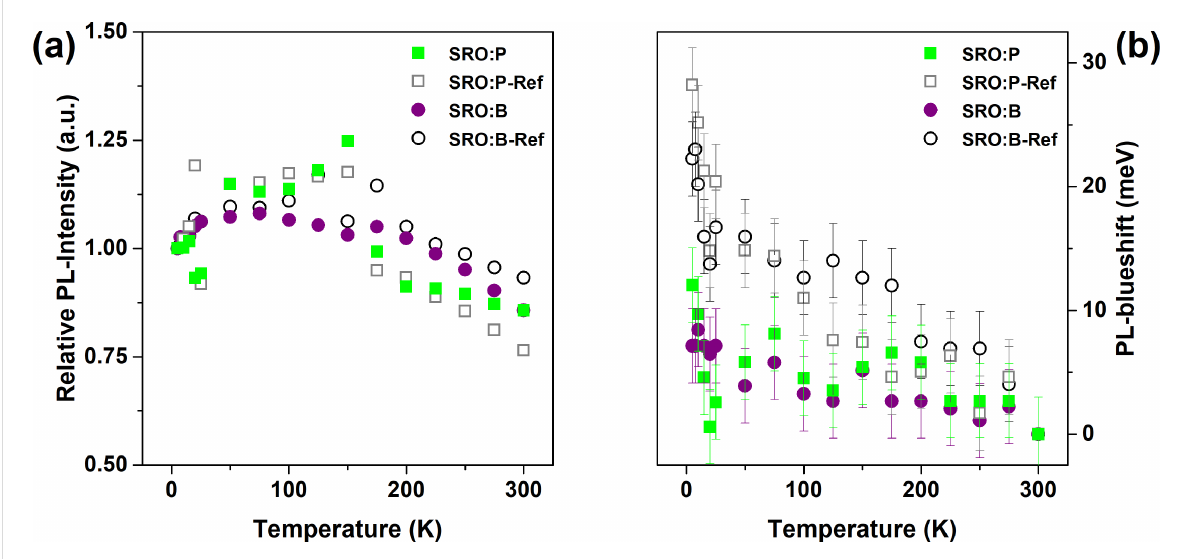
Figure 4: Low-temperature PL data of samples with 5 nm SRO and 0.59 atom % P (SRO:P), 0.47 atom % B (SRO:B) and their respective intrinsic references (SRO:P-Ref, SRO:B-Ref). (a) Relative PL-intensities with respect to the measured value at 5 K of each sample, i.e., the lowest tempera- ture where all potential dopant-induced carriers are completely frozen out. There is hardly any difference visible in the PL-intensity over temperature between doped and undoped samples. (b) PL peak shift with reference to the peak at 300 K, i.e., where ionized donors and acceptors would quench predominantly the largest NCs in each sample. A slight PL-blueshift is observed, not a redshift as expected from NC-doping.